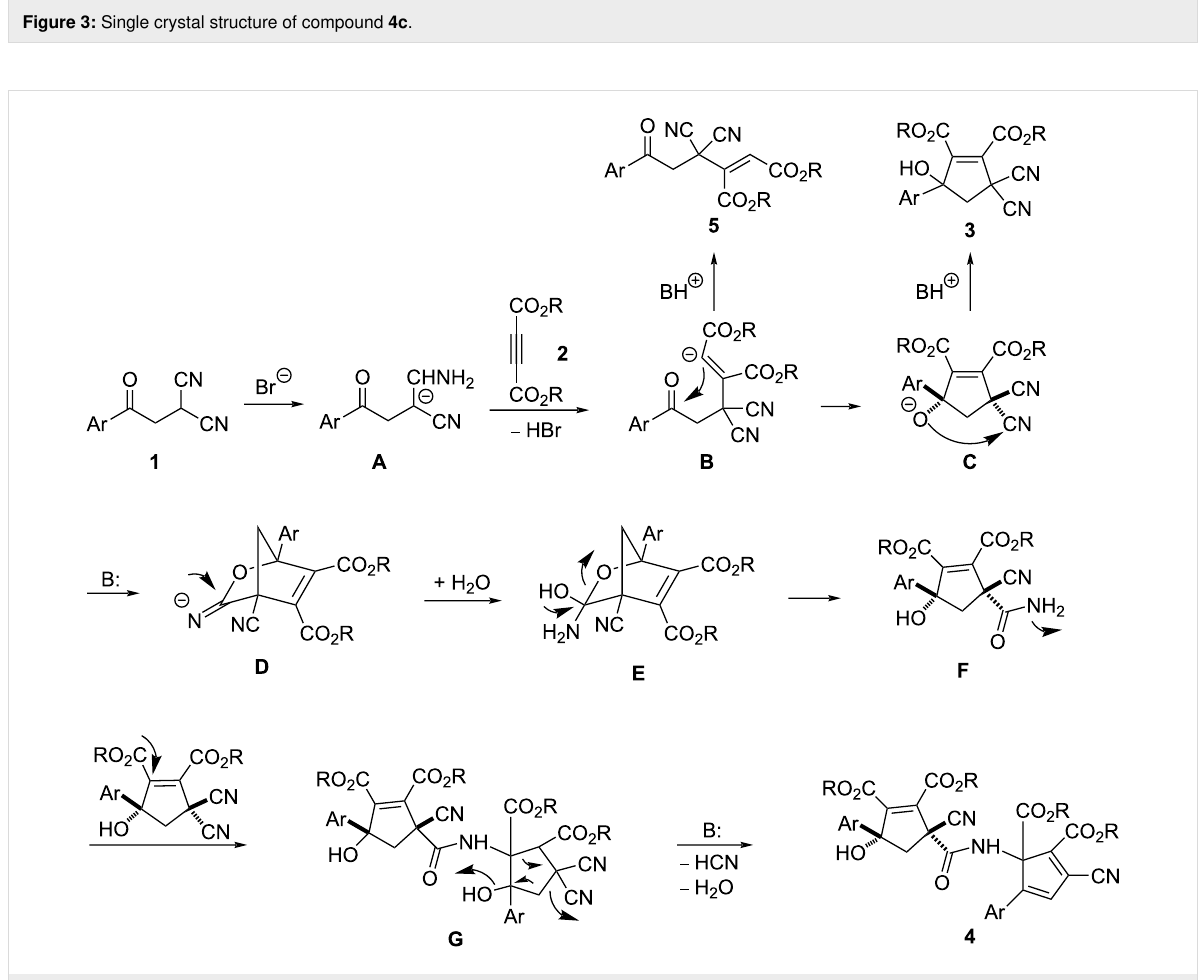
Scheme 2: Proposed reaction mechanism for compounds 3 , 4 , and 5